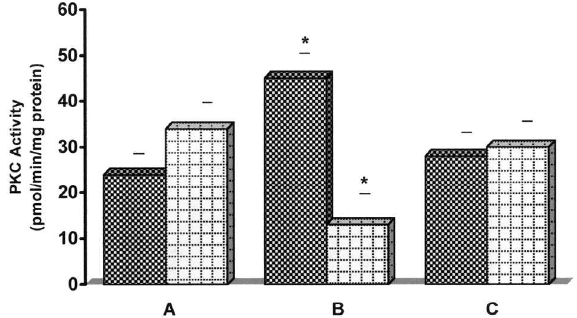
FIG. 2. Activation by ThEA of PKC. PKC activity was determined in both the membrane and cytosol of rat submandibular gland slices. The effect of the H 1 receptor agonist (1 ´ 10 –7 M) ThEA alone (B), or in the presence of the H 1 receptor antagonist (1 ´ 10 –6 M) pyrilamine (C) above basal values (A) was analysed. Results presented as the mean ± SEM of six experiments performed in duplicate in each case. * Differ significantly from (A) with p < 0.001.